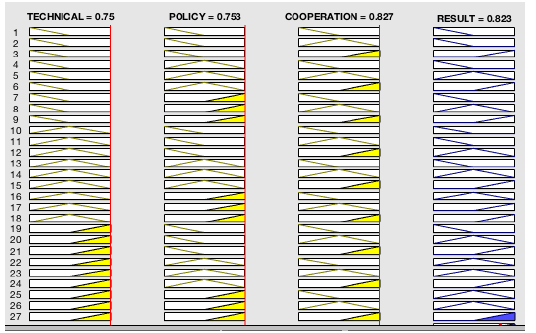
Fig. 7 Cooperation Success Index - Fuzzy